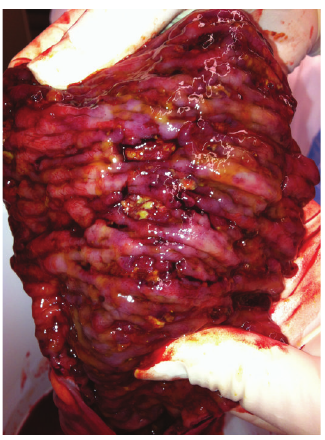
Figure 2: Postoperative specimen.